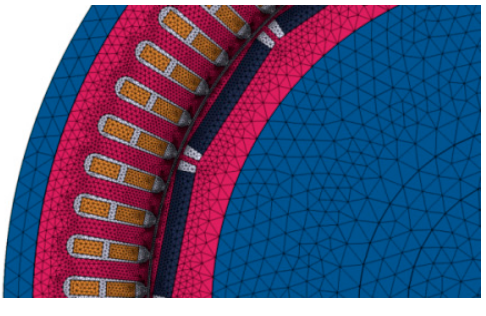
Figure 8. Grid diagram.